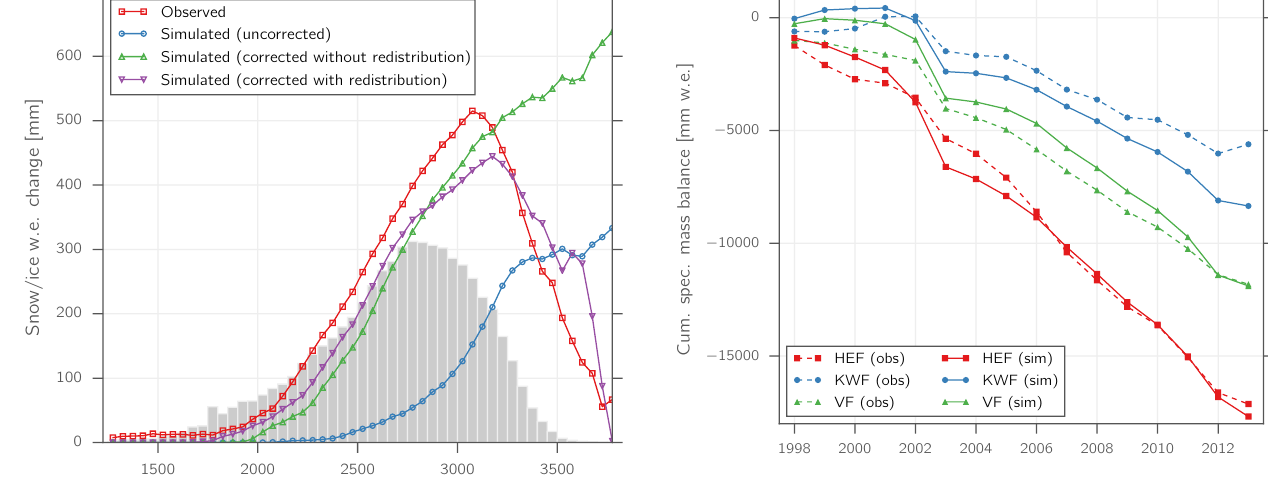
Figure 14. Observed (dashed) and simulated (solid) cumulative specific mass balance for Hintereisferner (HEF), Kesselwand- ferner (KWF), and Vernagtferner (VF) in the period 1997/1998–